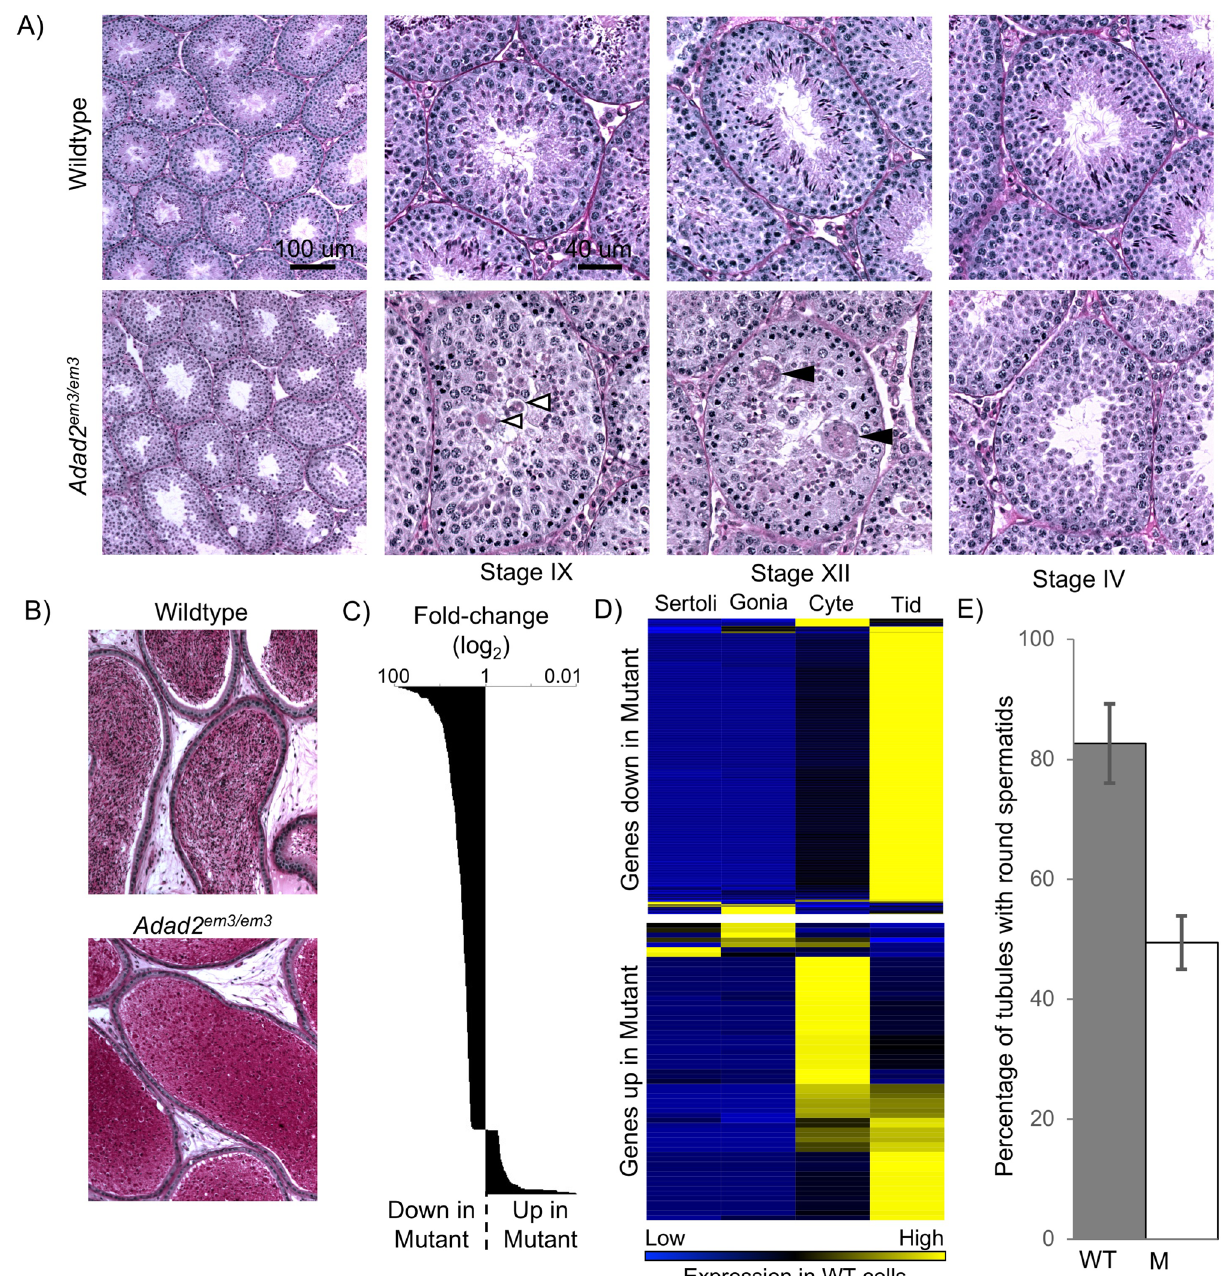
Figure 4. Knockout of Adad2 results in germ cell development defects distinct from Adad1 . ( A ) PAS-stained adult testis from wildtype and Adad2 em3/em3 animals showing abnormal post-meiotic germ cell differentiation associated with a gradual loss of post-meiotic germ cells. Stage of the seminiferous epithelium indicated by Roman numerals. White arrowheads—abnormal elongating spermatids. Black arrows—multinucleated cells. ( B ) PAS-stained adult epididymis from wildtype and Adad2 em3/em3 animals showing lack of spermatozoa in mutant epididymis. ( C ) Gene expression assessed in late juvenile Adad2 em3/em3 whole testis as compared to wildtype by RNA-sequencing. ( D ) Cell-type expression profiles (derived from wildtype cells) of genes down or up-regulated in mutant testis. Data derived from 23 . ( E ) Quantification of seminiferous tubule cross-sections with round spermatids in late juvenile testes of wildtype (WT) and Adad2 em3/em3